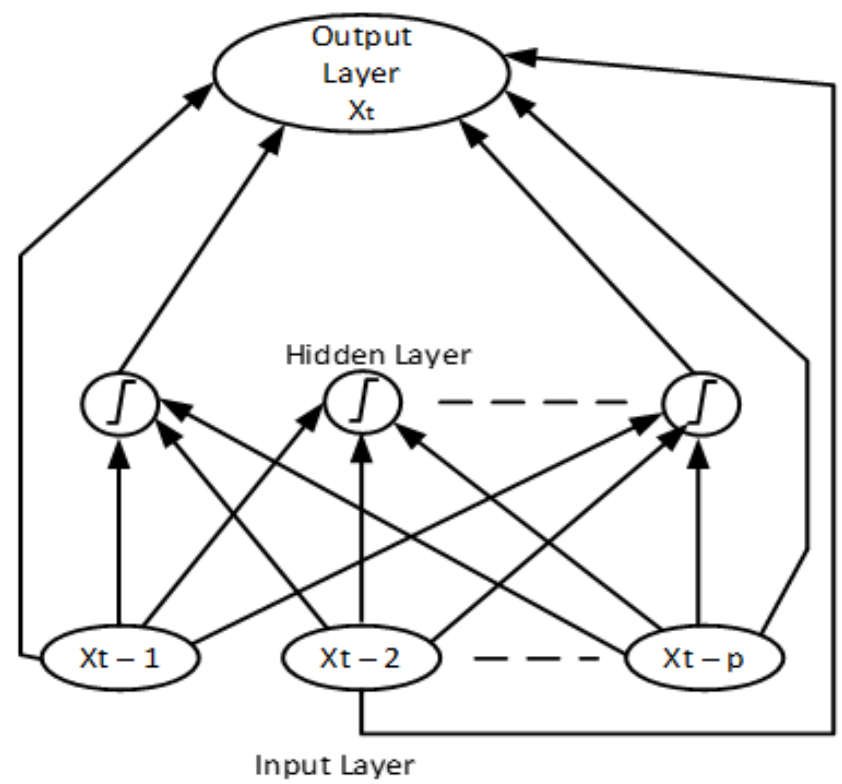
x n Figure 2. The architecture of the feedforward neural network (FFNN) [24,26,33]. 4.2. Cascaded Forward Neural Network (CFNN) When the connection from the perspicacity and multilayer network is integrated, the system has direct linking where the input and output layers are shaped. Such a designed system is called the CFNN [35]. The perceptron and link that is shaped between the input